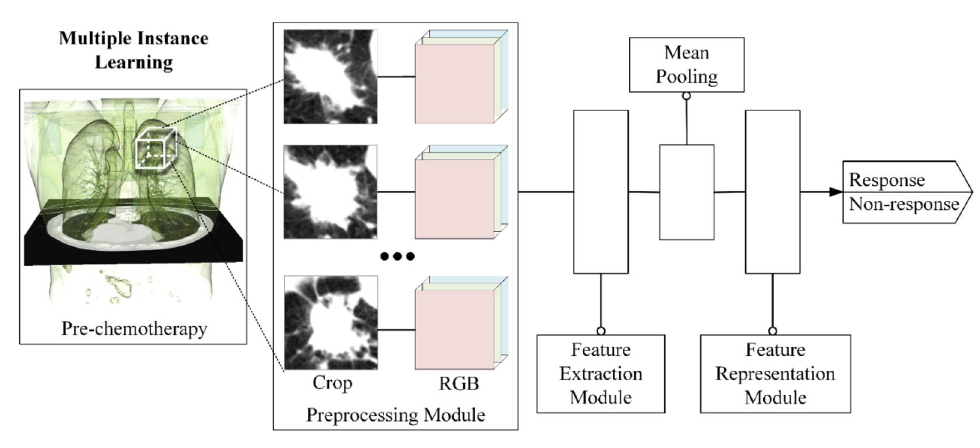
Figure 1. Flowchart of the